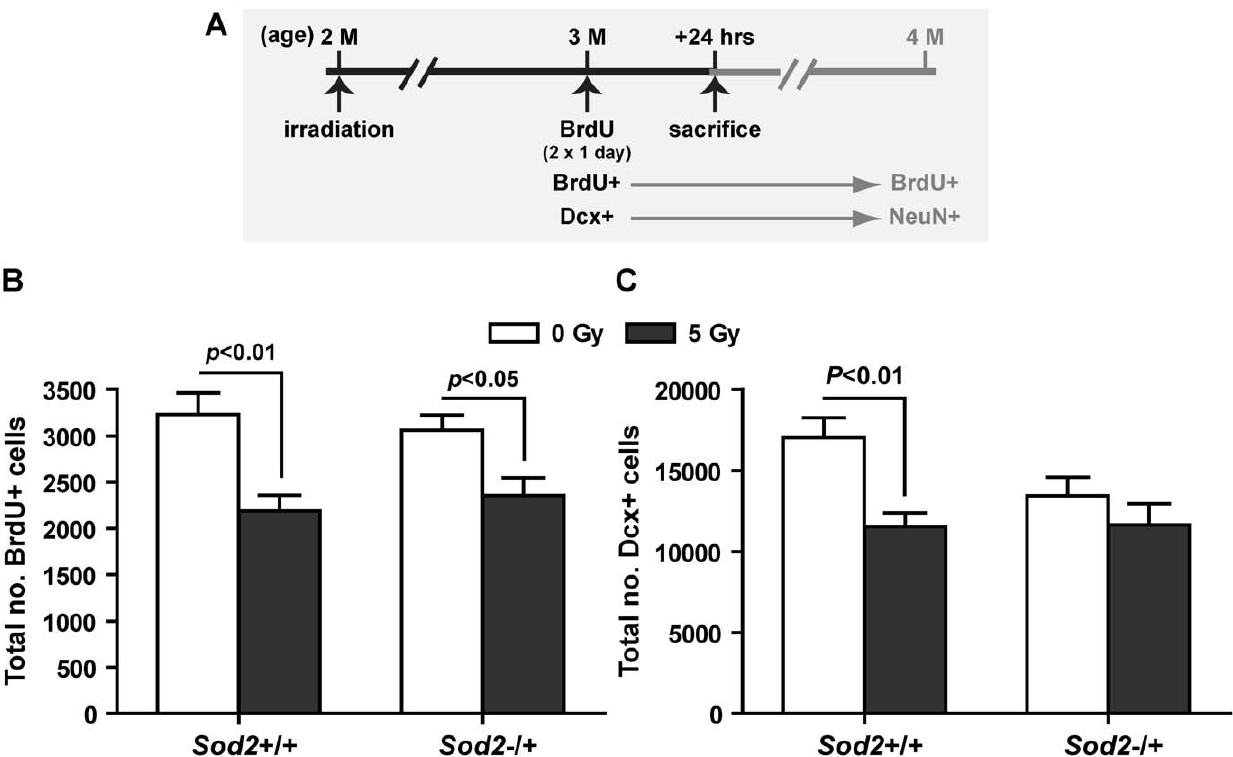
Figure 1. Number of proliferating cells and early lineage commitment in the SGZ. A, experimental timeline. Cells were labeled with BrdU at 4 weeks after irradiation (i.e. at 3 months of age) with two injections (8 hours apart) and sacrificed 24 hours after the first injection. The expected cell identities (BrdU + R BrdU + ; Dcx + R NeuN + ), if were allowed to continue the maturation process for another month, were also depicted. B, the number of proliferating cells (BrdU + ) in the SGZ. C, the number of immature neurons (Dcx + ) in the SGZ. Two-way ANOVA with Bonferroni post test was carried out. Radiation was the major source of variation in BrdU ( F (1,21) =20.13, p=0.0002) and Dcx ( F (1,16) =9.30, p=0.0077) analyses, and there was no genotype 6 treatment (radiation) interaction. P values indicate results from Bonferroni post tests. Data are presented as mean 6 SEM. Sample size (in the order of Sod2 + / + /0 Gy, Sod2 + / + /5 Gy, Sod2 2 / + /0 Gy, and Sod2 2 / + /5 Gy): BrdU, n=6, 5, 7, and 7; Dcx, n=6, 5, 4, and 5. 48 hrs at 4 u C followed by biotinylated rabbit anti-goat IgG (BA-